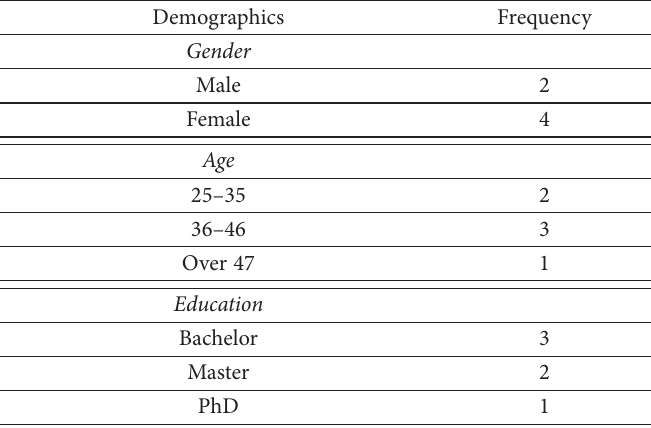
Table 4. Demographic characteristics of decision making team